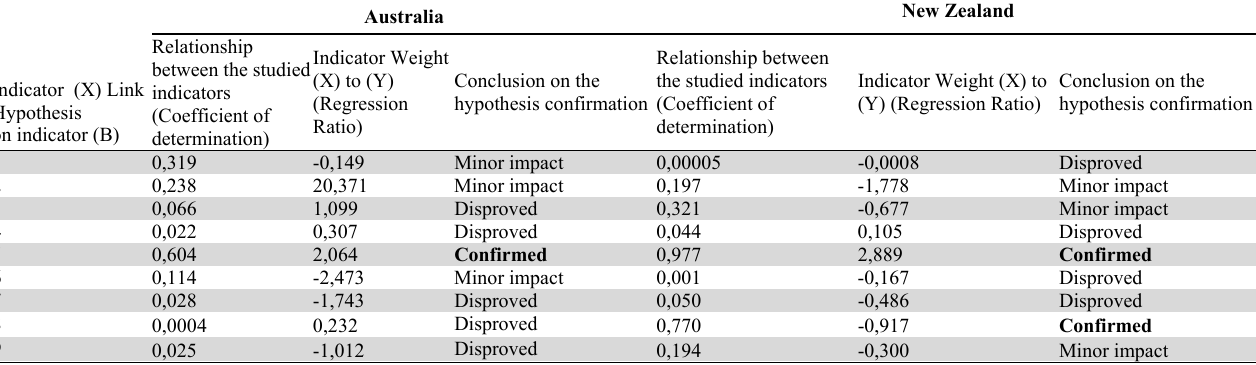
Indicator (X) Link